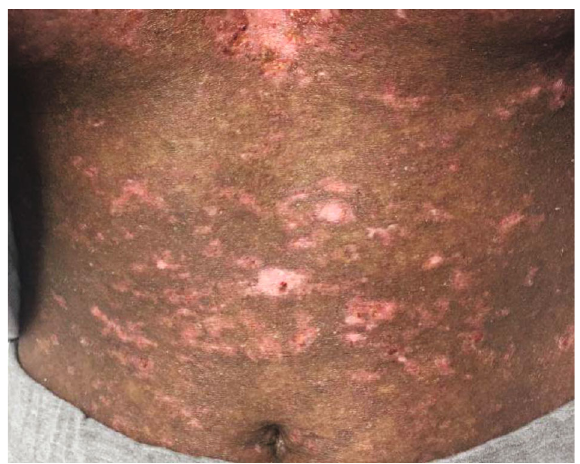
Figure 4: Dyspigmentation apparent during gradual resolution of this rash in subacute cutaneous lupus